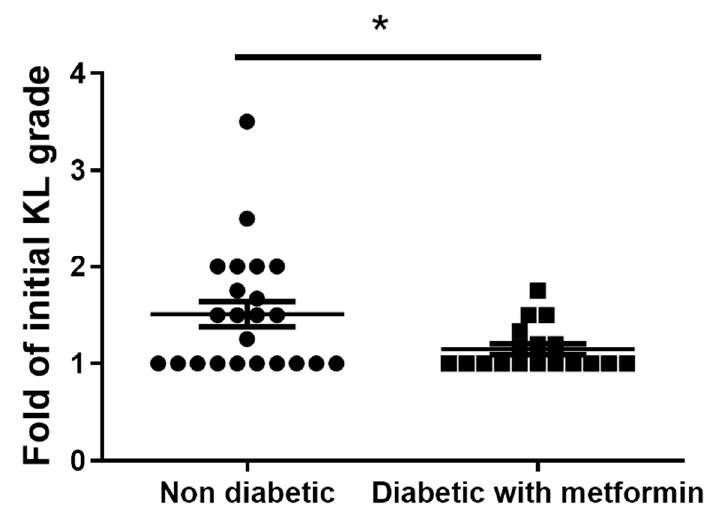
Figure 7. Clinical study of the effect of metformin in OA patients. A clinical assessment of OA patients with type 2 diabetes, who had been followed-up for >3 years, showed slower progression of OA in those taking metformin (nondiabetic = 23 patients, diabetic with metformin = 18 patients; all patients female). The OA grade was analyzed based on 3 years of data (* p < 0.05).